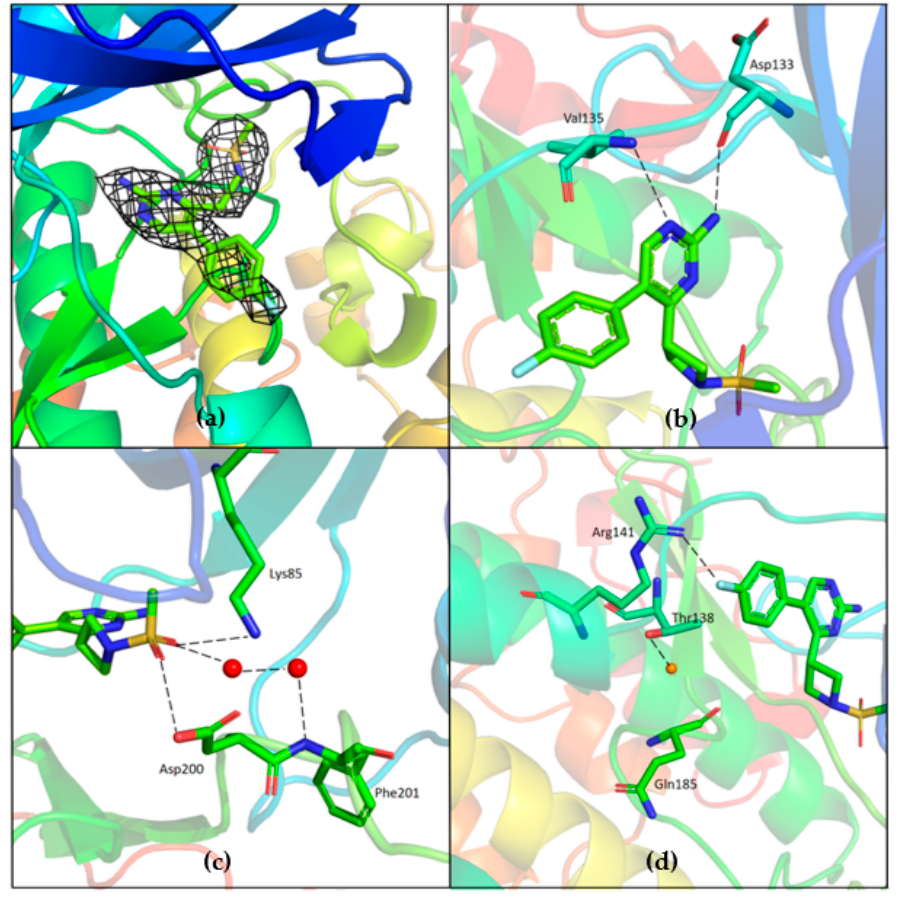
Figure 7. ( a ) Electron density corresponding to G5 contoured at 1.2 sigma; ( b ) Direct hydrogen bonding interaction between the core pyrimidine 2-amine of G5 with the backbone oxygen of Asp133 and nitrogen of Val135; ( c ) Hydrogen bonding interactions of methyl sulfonyl group of G5 with Lys85 and Asp200. Water (red spheres) mediated hydrogen binding network is also observed; ( d ) Conserved water (red sphere) is observed hydrogen-bonded to Thr138. Fluorine of fluoro-phenyl is hydrogen-bonded to Arg141; PDB 7U31.